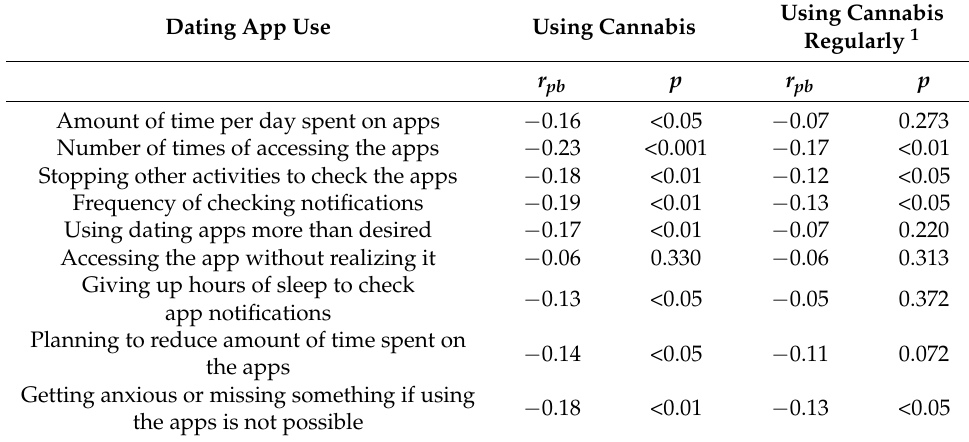
Table 4. Point-biserial correlations ( r pb ) testing the association between the cannabis use variables (using cannabis and cannabis regularly) and the variables related to dating app use in the sample of active users. Note that when the Bonferroni correction is applied, the significance level is set at 0.005. Dating App Use